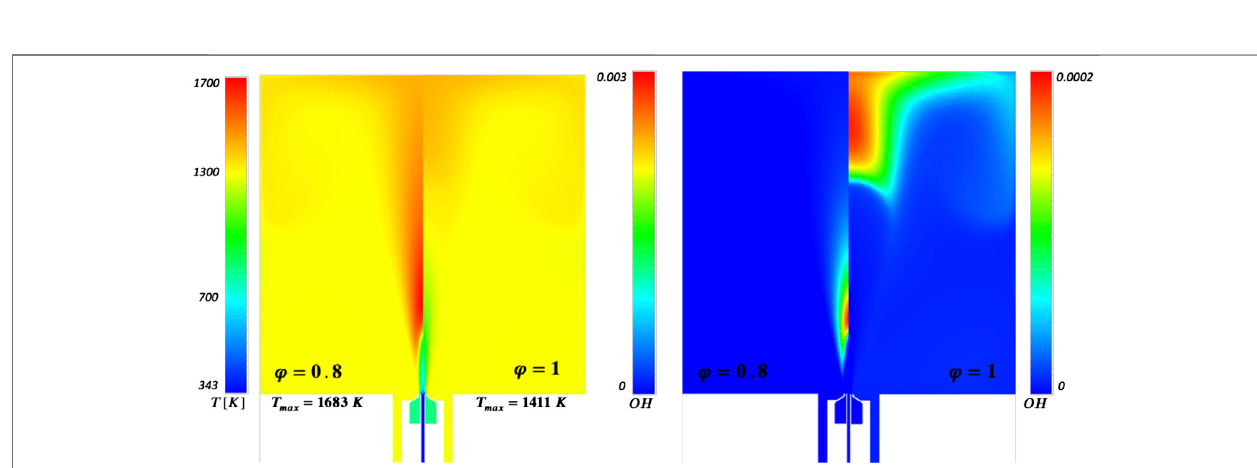
FIGURE 6 | Temperature and OH fi elds comparison for different equivalence ratios with 50% H 2 content (cases 5 – 6).